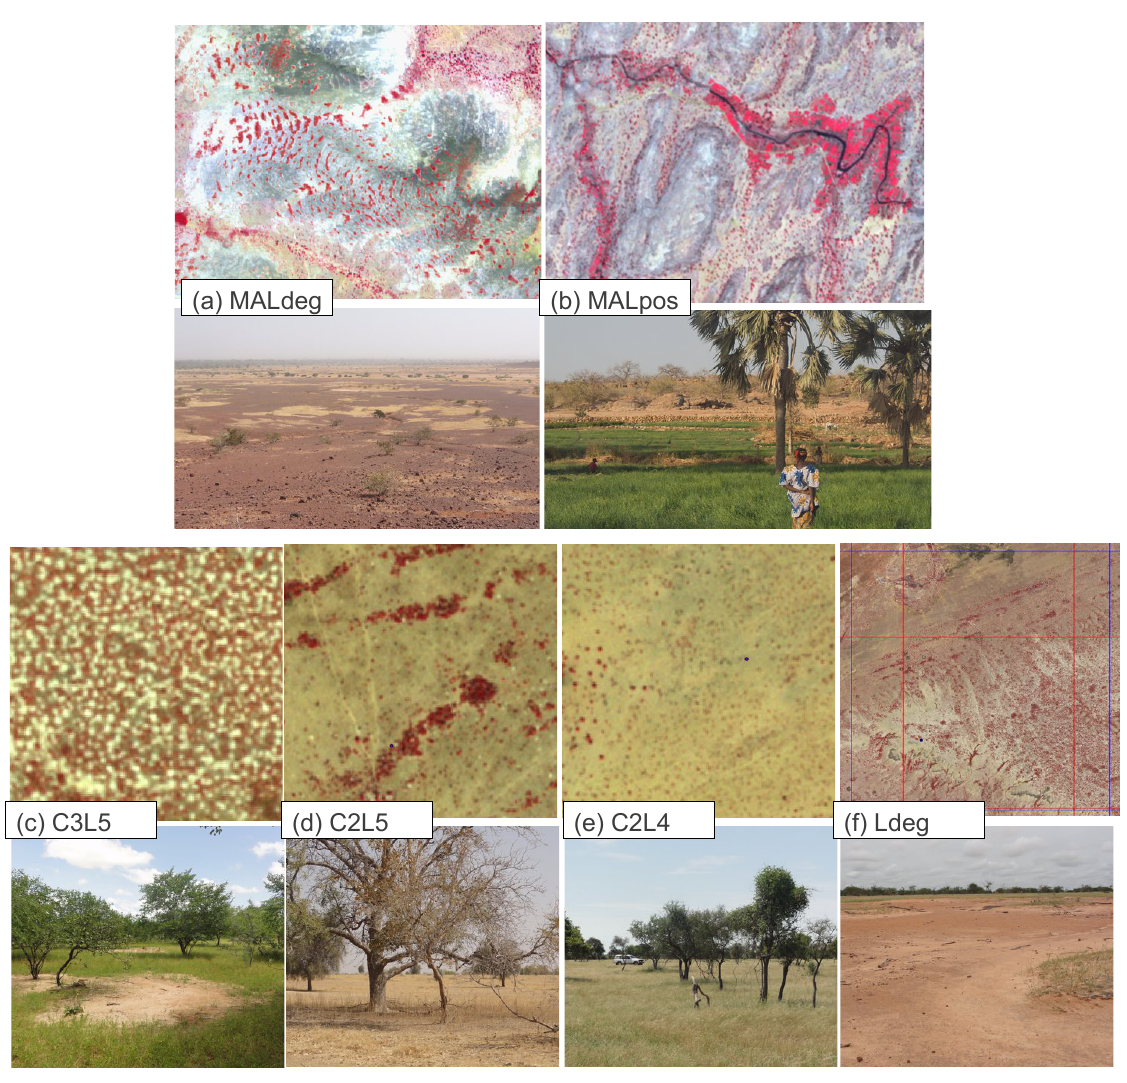
Figure 1. Study sites in Mali ( a , b ) and Senegal ( c – f ); illustrated by RapidEye images [32] (bands 532, December 2010) and photos, taken in December 2011 ( a,b); March 2012 (d) and September 2012 (c,e,f). Site (a) is located on the lateritic Dogon Plateau with small spots of bushland left, visible as red spots in RapidEye. Degradation (dark color) fills up most parts of the image. Onion plantations (bright red) are present at (b) and stay green into the dry season due to irrigation. The rocky surroundings are covered by Combretum micranthum shrubs. Site (c) illustrates the ferruginous Ferlo with a dense shrubby vegetation dominated by Pterocarpus lucens, Guiera senegalensis and Boscia senegalensis but also unvegetated spots; (d) represents the southern sandy Ferlo, intersected by forested depressions. Sclerocarya birrea and Balanites aegyptiaca are seen on the dry season photo; Site (e) is located in the northern sandy Ferlo with an open tree and shrub savanna. Small Combretum glutinosum and Balanites aegyptiaca , severely cut by humans can be seen on the photo; Site (f) reveals different details in different resolutions: while the GIMMS pixel (blue grid) mixes the degraded area with peanut-fields further north, the GEOV1 (red grid) pixel captures the largely degraded